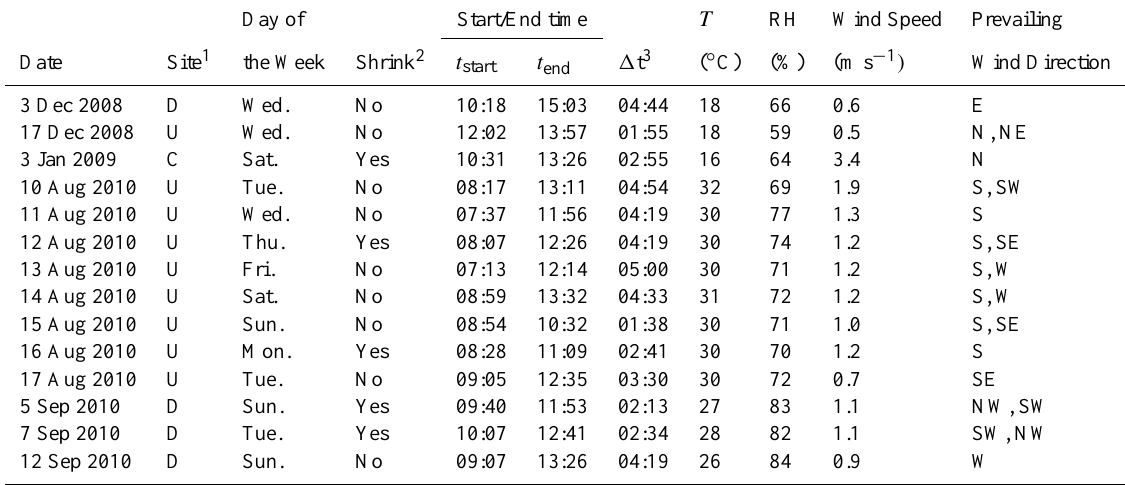
Table 1. The NPF and growth event date, time, duration, and daily averages of ambient temperature ( T ), relative humidity (RH), wind speed, and prevailing wind direction at the observation sites. Day of Start/End time T RH Wind Speed Prevailing Date Site 1 the Week Shrink 2